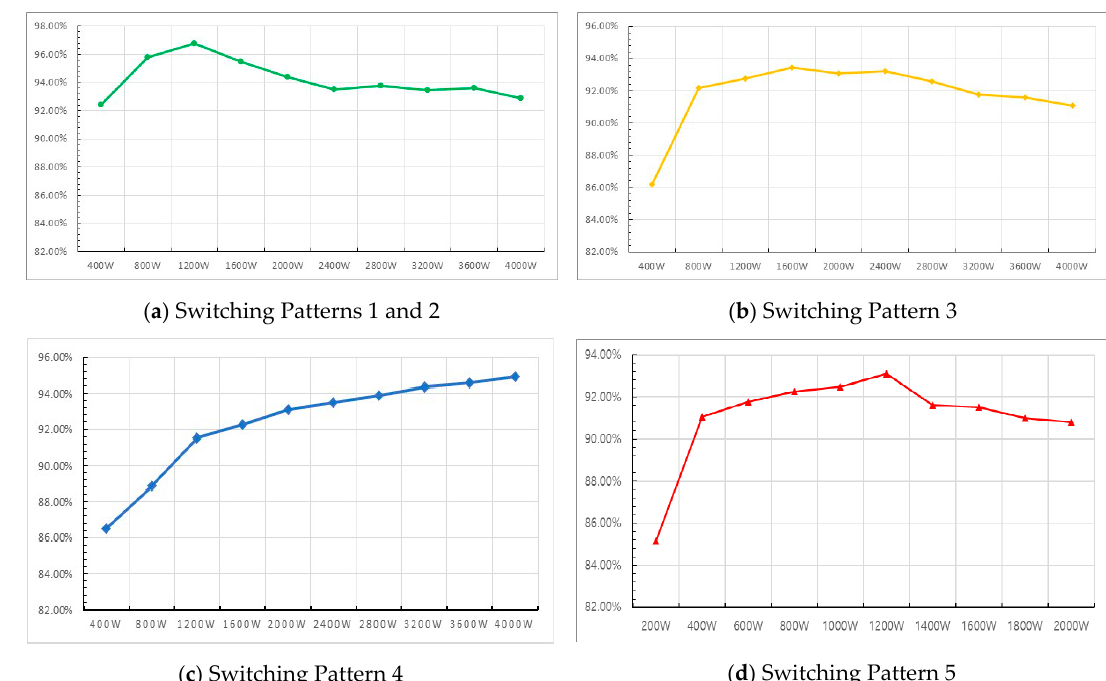
ffi ciency depending on the switching Figure 22. Efficiency depending on the switching patterns. Figure 22. E